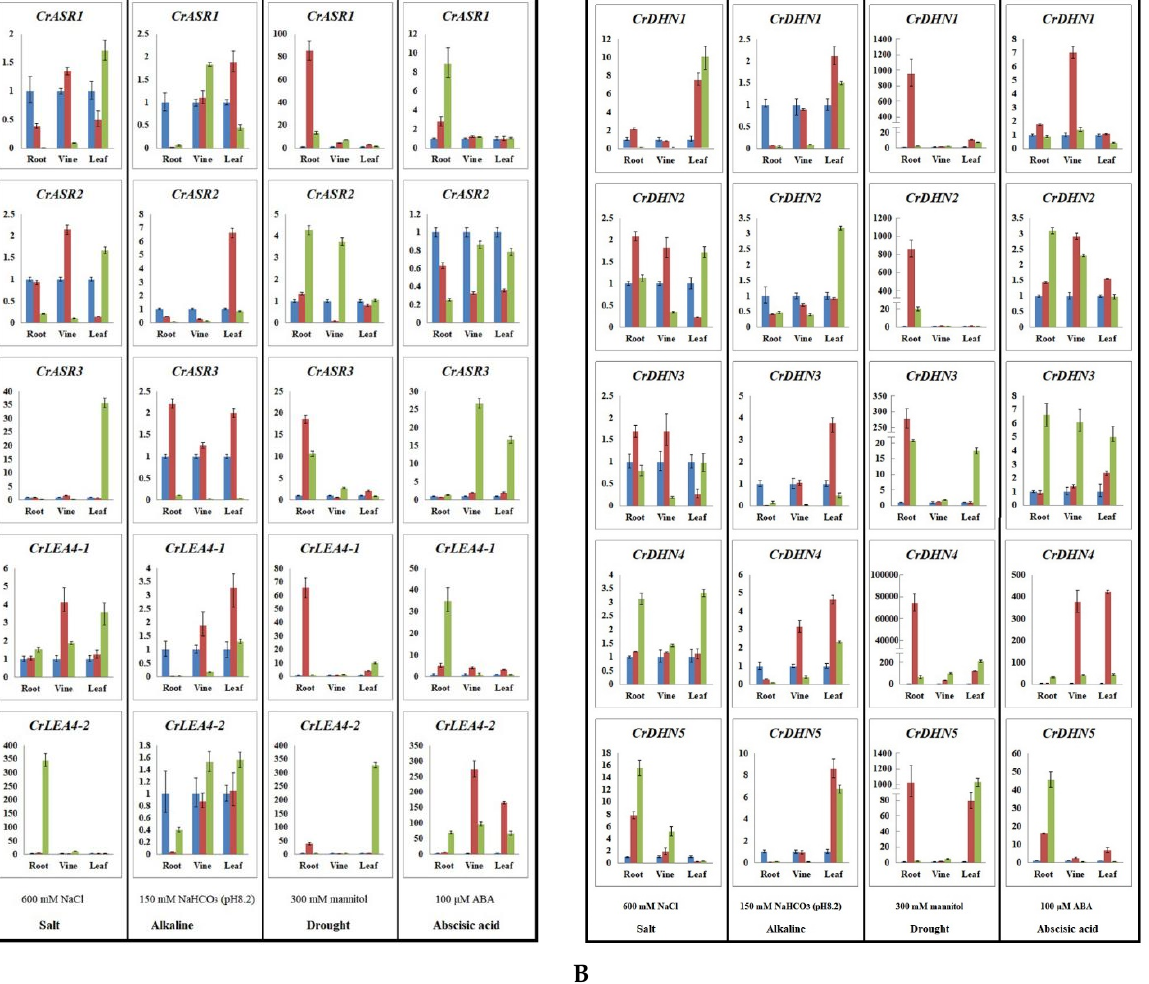
Figure 7. Quantitative RT-PCR detection of the expression levels of the 10 CrLEA/CrASR genes responding to different stresses (600 mM NaCl, 150 mM NaHCO 3 , 300 mM mannitol, or 100 mM ABA) in C. rosea seedling plants. ( A ) 3 CrASR s and 2 CrLEA_4 s. ( B ) 5 CrDHN s. Relative expression values were calculated using the 2 −Δ Ct method with housekeeping gene CrEF- α as reference gene.